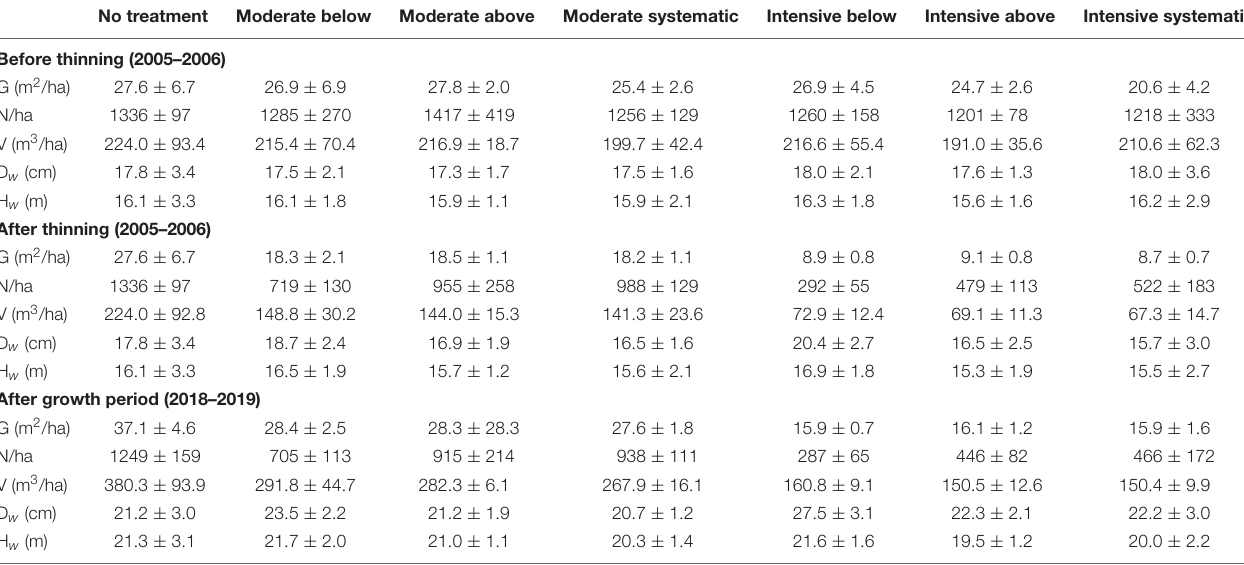
TABLE 1 | Mean and standard deviation (with ± ) of stand characteristics by treatments before and after the thinning treatments (2005–2006) and also after the growth period (2018–2019). No treatment Moderate below Moderate above Moderate systematic Intensive below Intensive above Intensive systematic